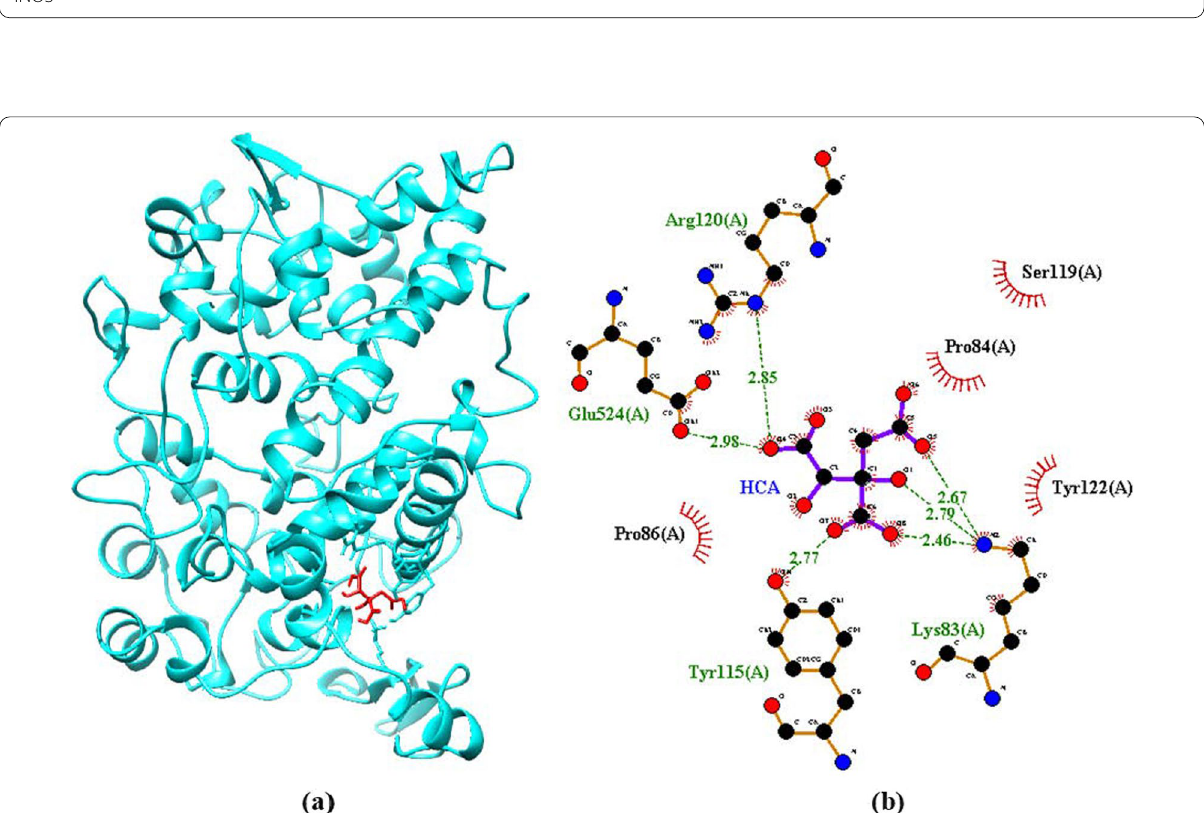
Fig. 12 Docking images of protein (COX-2) and ligand (Hydroxycitric acid). a Shows the 3D interaction between HCA (red) and COX-2 (blue). b LigPlot image showing the H-bond interactions (Lys83, Tyr115, Arg120, Glu524) and hydrophobic interactions (Pro84, Pro86, Ser 119, Tyr122) + between HCA and